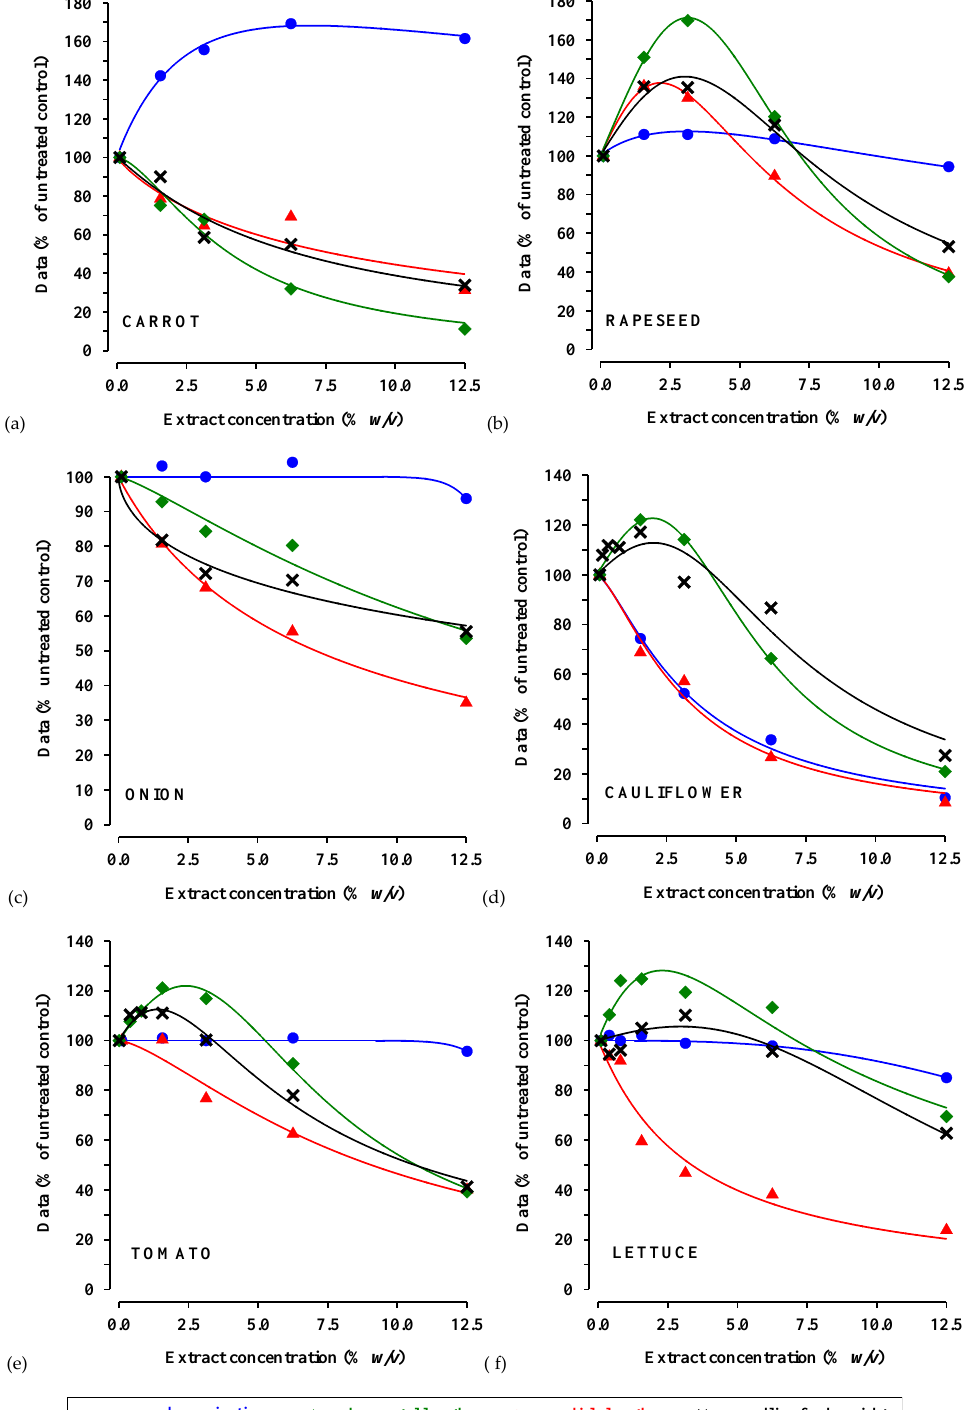
Figure 1. Dose–response curves of seed germination, hypocotyl length, radicle length and seedling weight of the tested crops at different mugwort aqueous extract concentrations (% w/v ). Symbols show observed data in the bioassay experiments, and lines show fitted curves according to log-logistic models 1 and